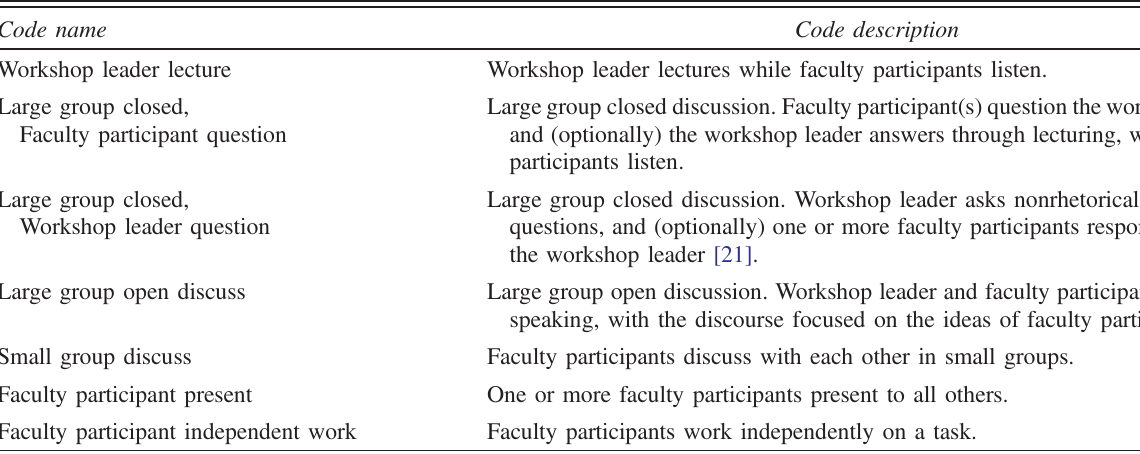
TABLE I. Type-of-engagement code names and brief